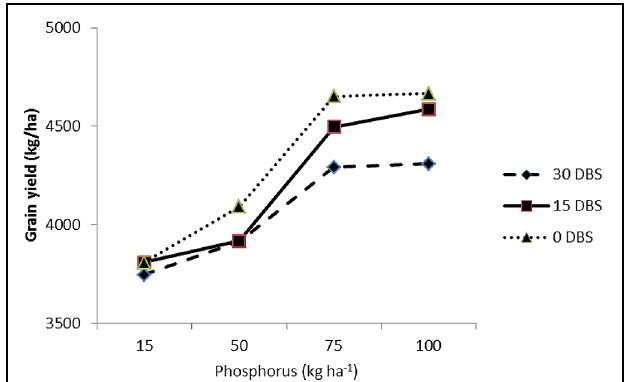
FIGURE 5 | Response of shelling percentage (%) of maize ( Zea mays L.) to compost application time (C) and phosphate solubilizing bacteria (PSB) interaction (C × PSB).